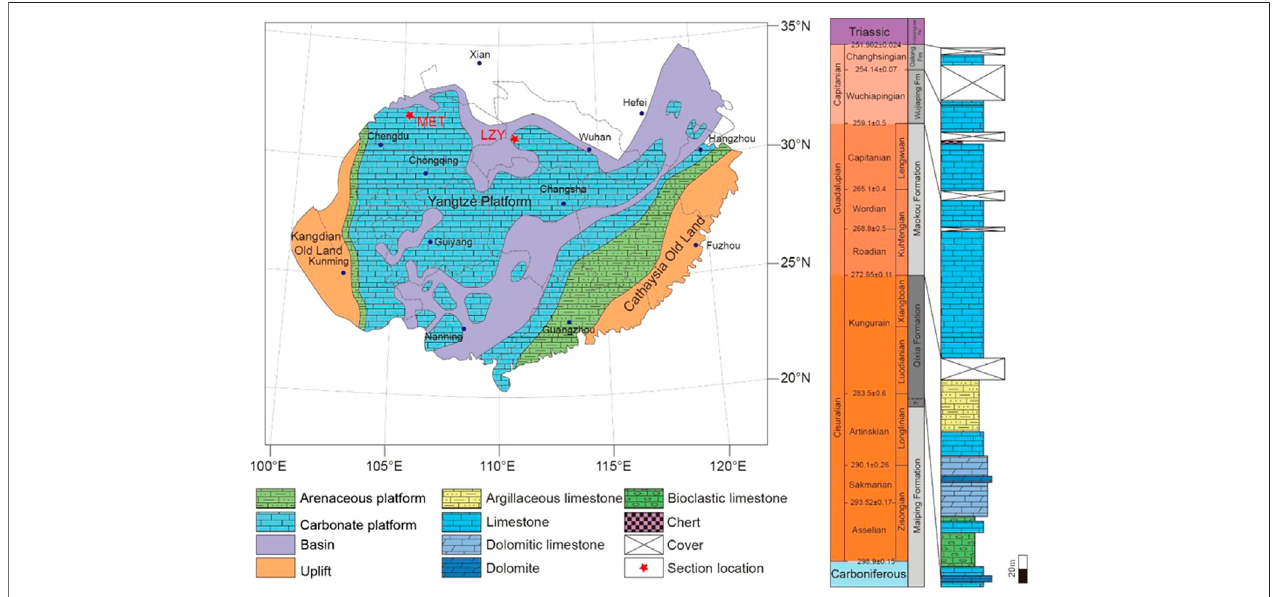
FIGURE1 | Paleogeographic map [modi fi ed from Wang and Jin, (2000)] and thestratigraphic column in the Permian (260 Ma) ofthe South China Block. Sampling localities are marked by red stars. LZY: The Lianziya section, MET: The Maoertang section. The geochronology data are modi fi ed from Shen et al. (2019).